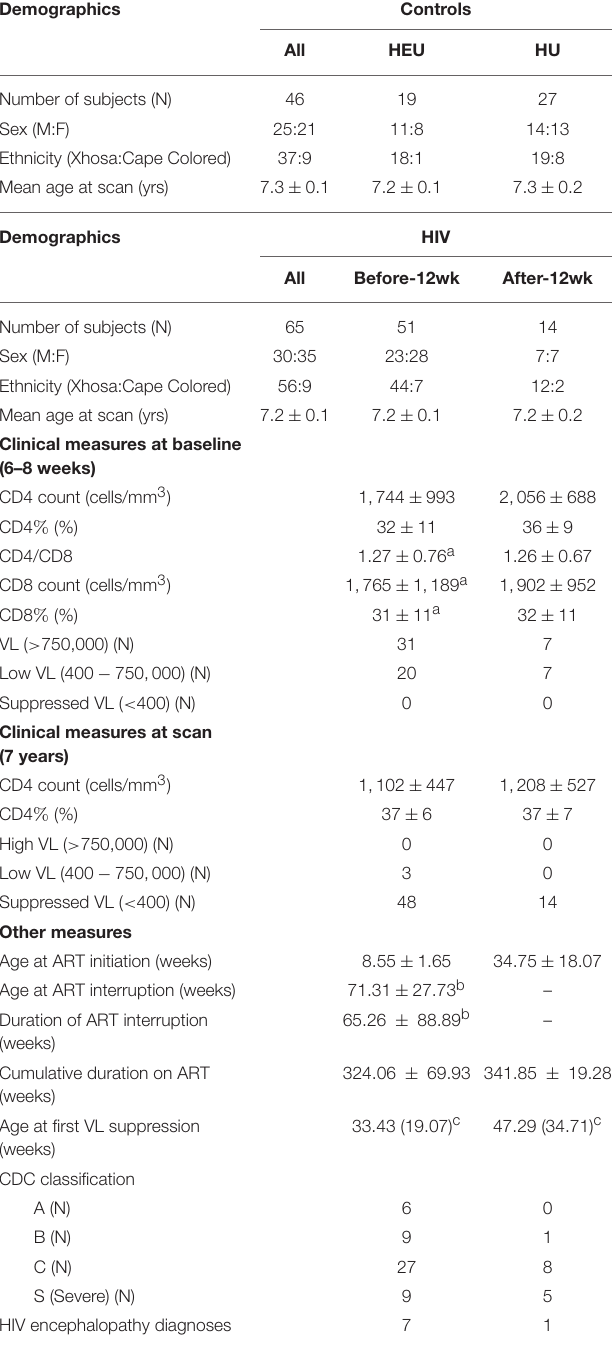
b AgeanddurationofARTinterruptionmeanandstandarddeviationbasedonlyonchildren in whom treatment was interrupted (N = 36). c Median and interquartile range.